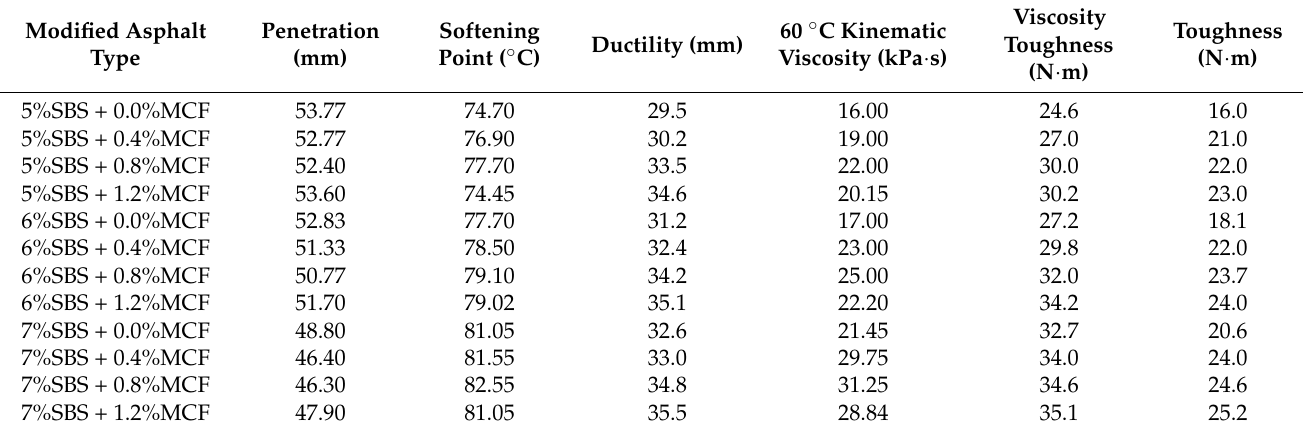
Table 5. Test results of basic indexes of modified